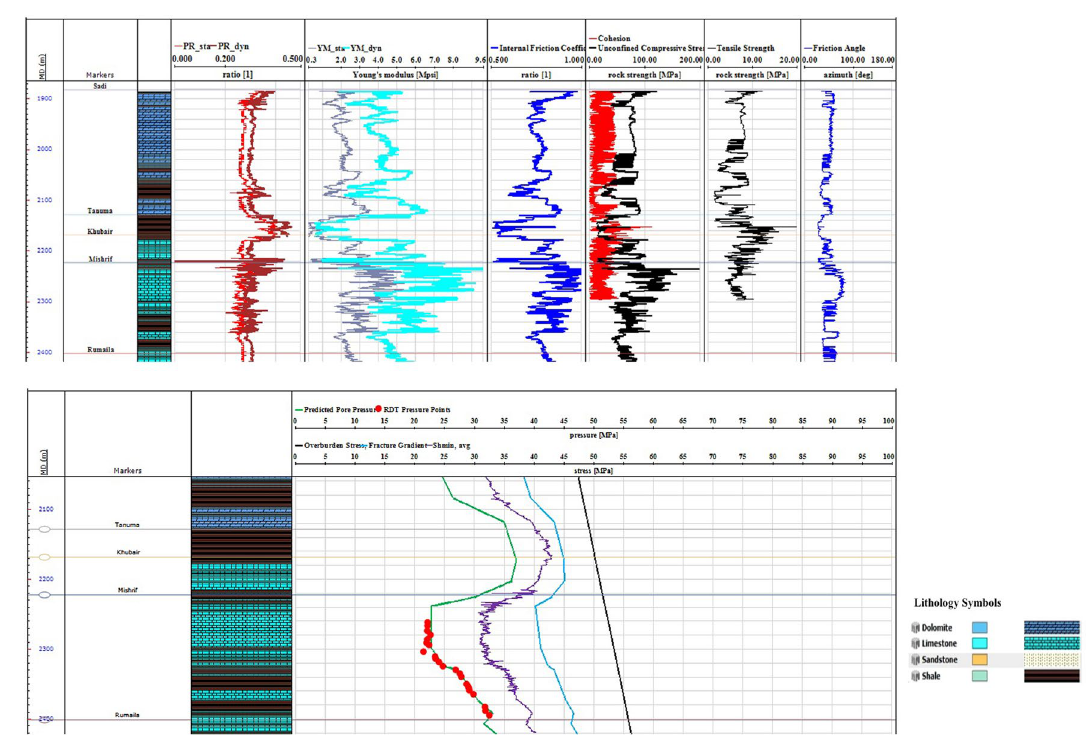
Fig. 3 1D MEM mechanical properties (upper), stresses and pore pressure (lower) (Al-Neeamy and Al-Zubaidi